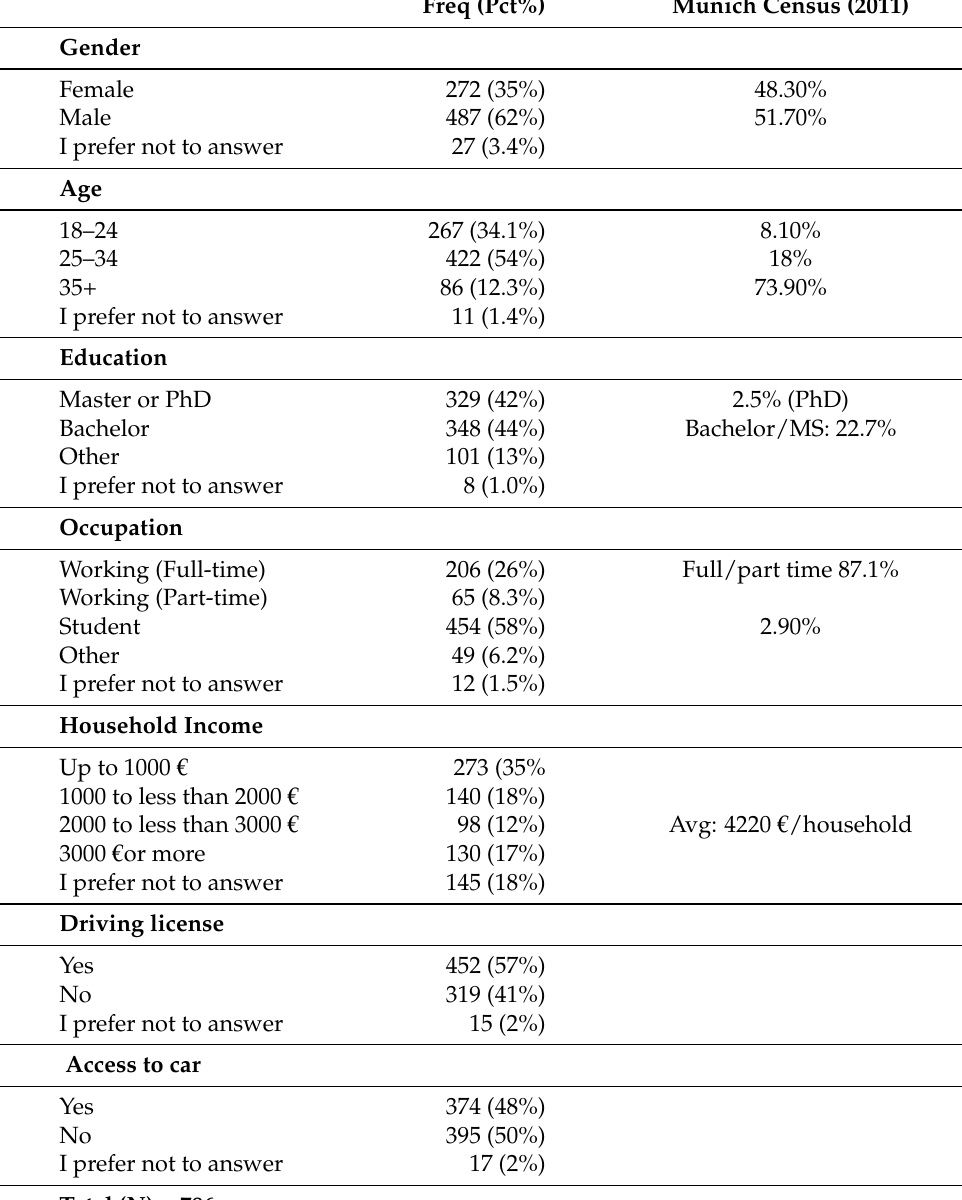
Table 3. Sample sociodemographic